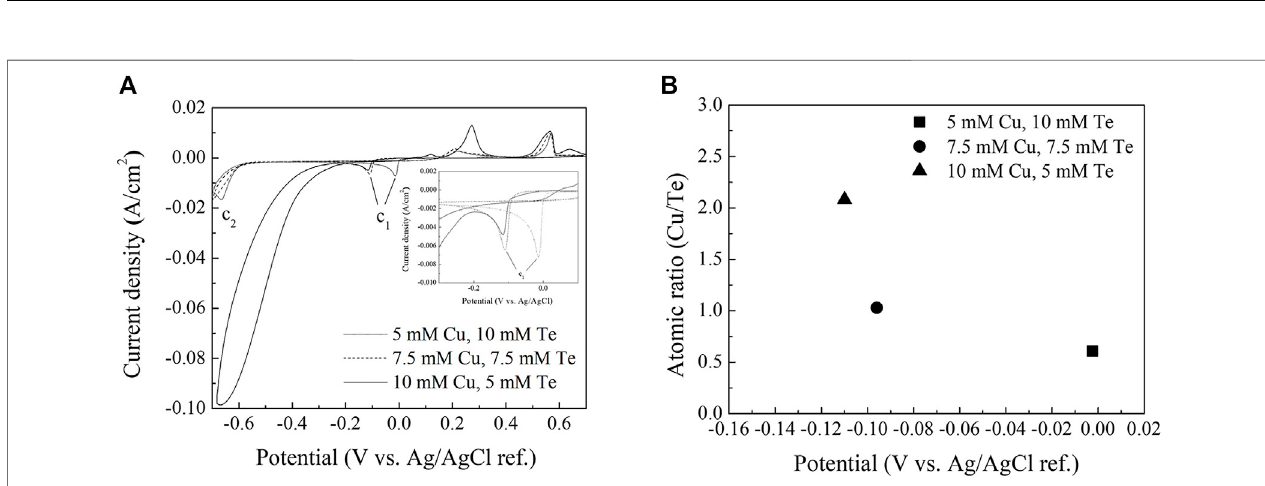
FIGURE 2 | (A) Cyclic voltammograms of a Au/Ti/Si substrate in Cu(NO 3 ) 2 · 3H 2 O/TeO 2 /HNO 3 between − 0.7 and 0.7 V. The inset shows the same cyclic voltammograms between − 0.3 and 0.05 V (B) EDS data for thin fi lms deposited in each bath at various potentials ( − 2.5, − 96, and − 110 mV).